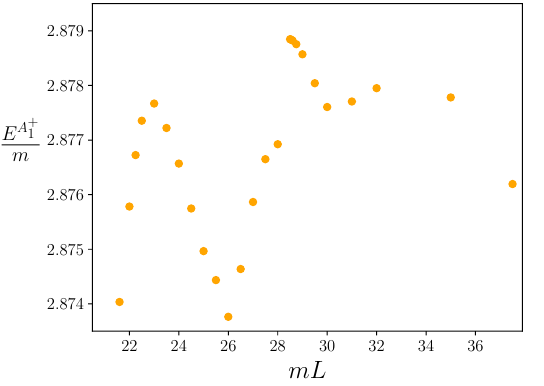
Figure 3. Energy levels as a function of ma 2 in the region E < 4 m with mL = 8 : 1 and ma 0 = (cid:0) 0 : 1, r 0 = P 0 = = 0 in the A + irrep (left) and the E + irrep (right). 1 K df ; 3